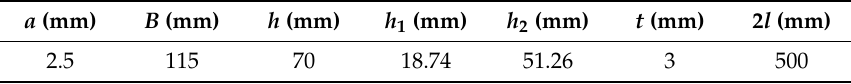
Table 3. Geometry of the U-section